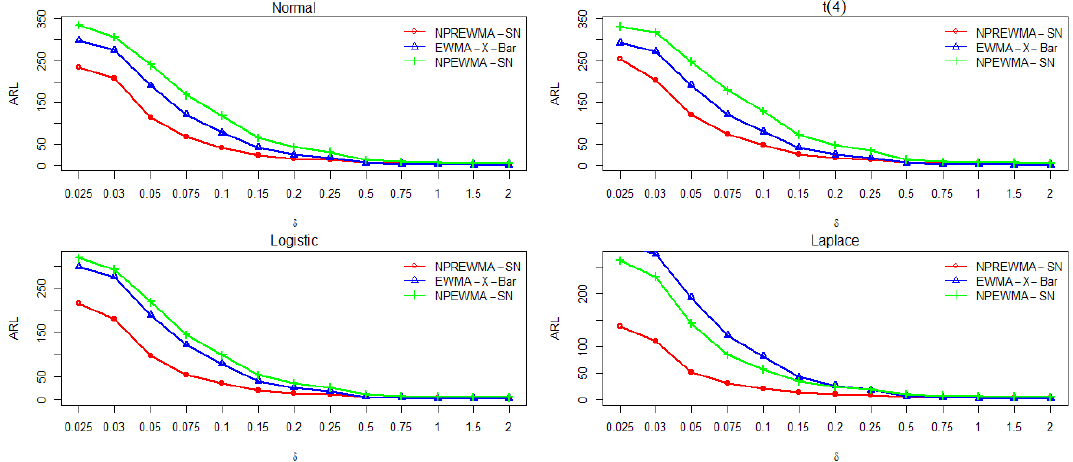
Figure 5. Overall comparisons of the proposed chart and its counterparts using ARL 1